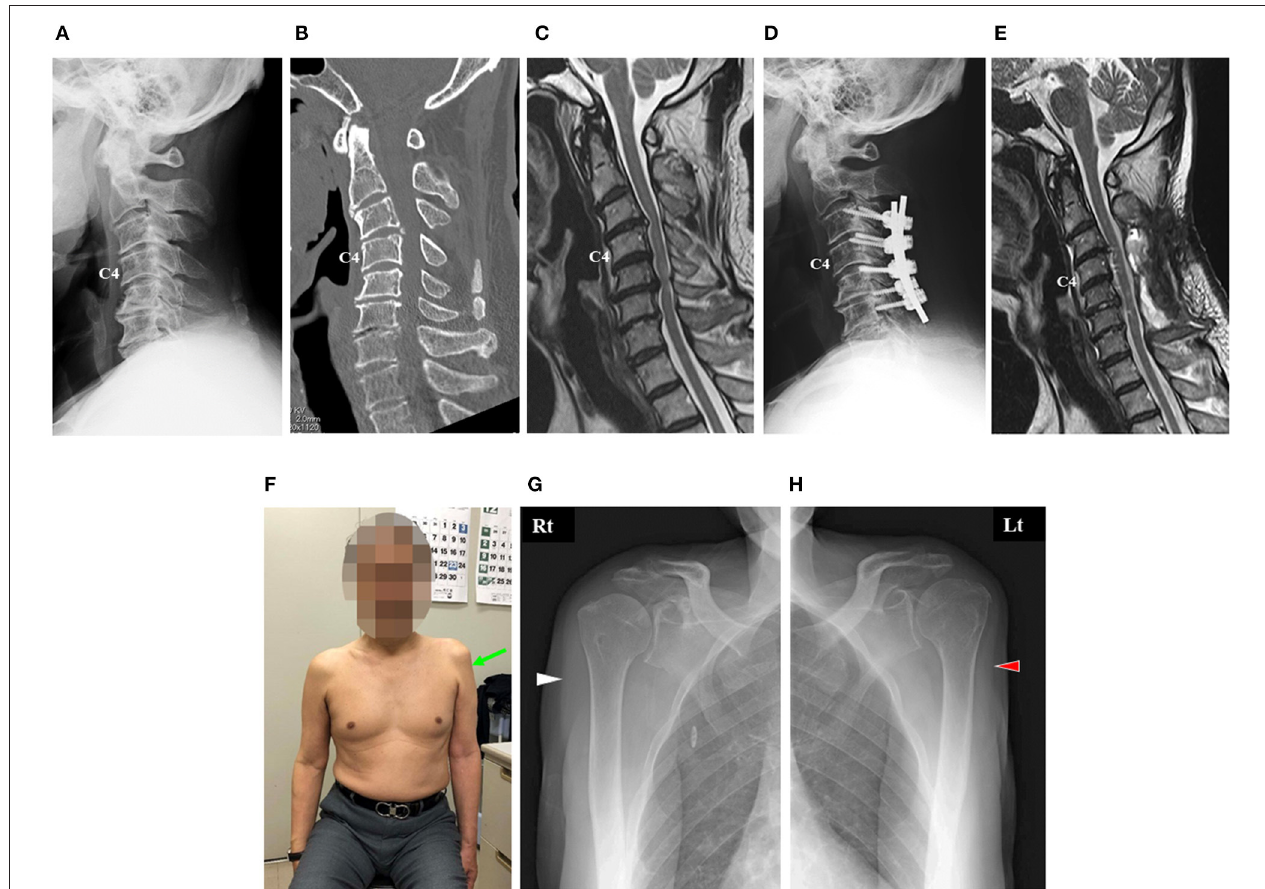
FIGURE 1 | Imaging findings of the cervical spine of the patient before surgery (A–C) . Image findings of his cervical spine after surgery (D,E) . Photograph and radiographs of the shoulders of the patient 7 months after surgery (F–H) . (A) Cervical lateral radiograph revealing slight kyphosis of his cervical spine. (B) Sagittal reconstruction computed tomography (CT) image revealing disc space narrowing with a posterior spur at C5–C6 and C6–C7 and postdiscal ossification at C3–C4. (C) Midsagittal T2-weighted magnetic resonance (MR) image revealing that the spinal cord was severely compressed anteriorly at C3–C4 and C5–C6. (D) Cervical lateral radiograph 2 weeks after surgery revealing instrumented fusion at C3–C6. (E) Midsagittal T2-weighted MR image 4 weeks after surgery revealing adequate decompression of the spinal cord. (F) Anterior view showing muscle atrophy around his left shoulder. (G,H) Anterior–posterior radiographs of his right shoulder (B) and left shoulder (C) showing marked muscle atrophy in his left deltoid (red arrowhead) compared with that in his right deltoid (white